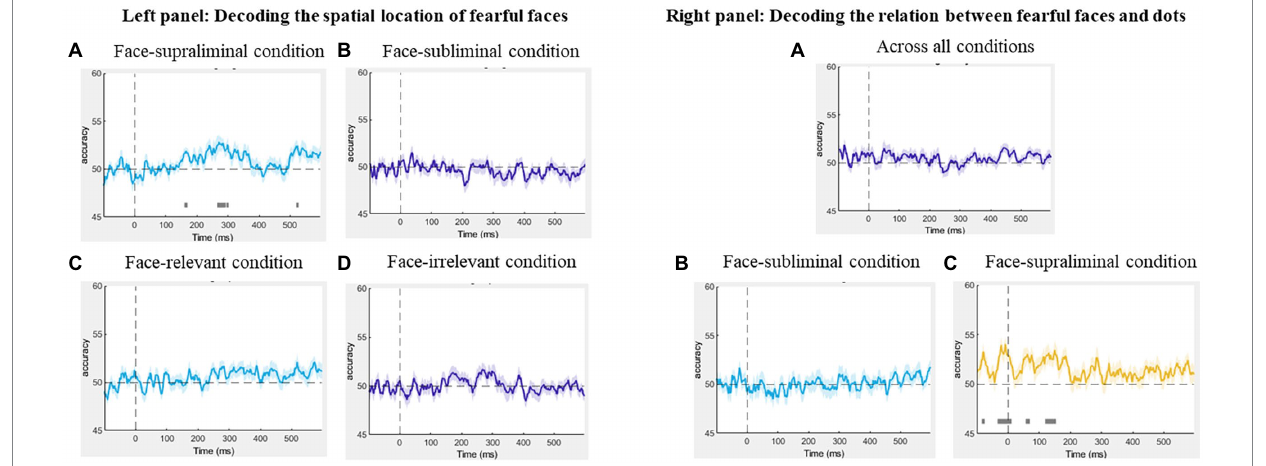
FIGURE 5 Left panel: Results of the decoding of spatial location of fearful faces in the (A) face-supraliminal condition, (B) face-subliminal condition, (C) face- relevant condition and (D) face-irrelevant condition. Right panel: Results of the decoding of the relation between fearful faces and the dots (A) across all conditions, (B) in the face-subliminal condition and (C) in the face-supraliminal